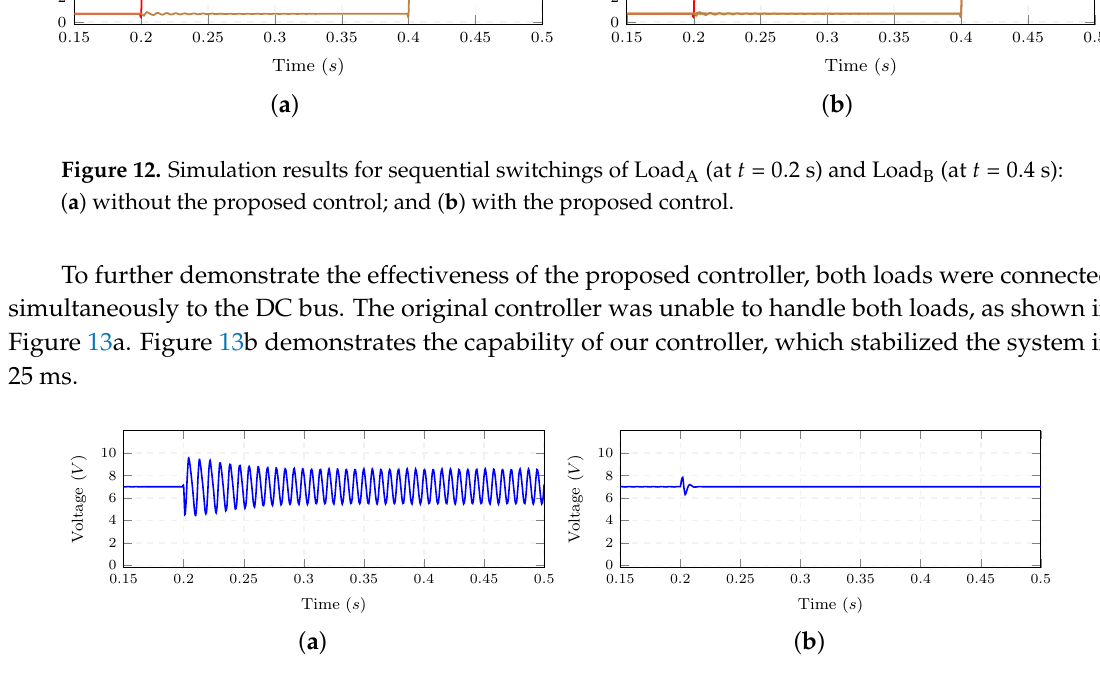
Figure 13. Simulation results for sequential switchings of Load A and Load B (at t = 0.2 s): ( a ) without the proposed control; and ( b ) with the proposed